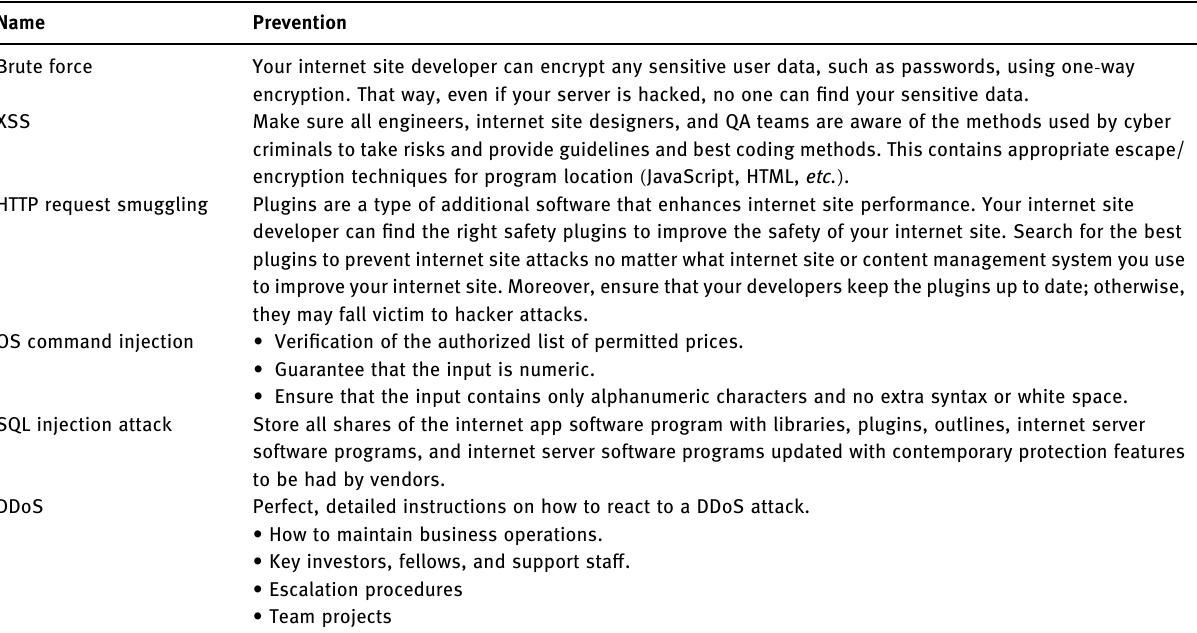
Table 2: Cyber - assaults and their